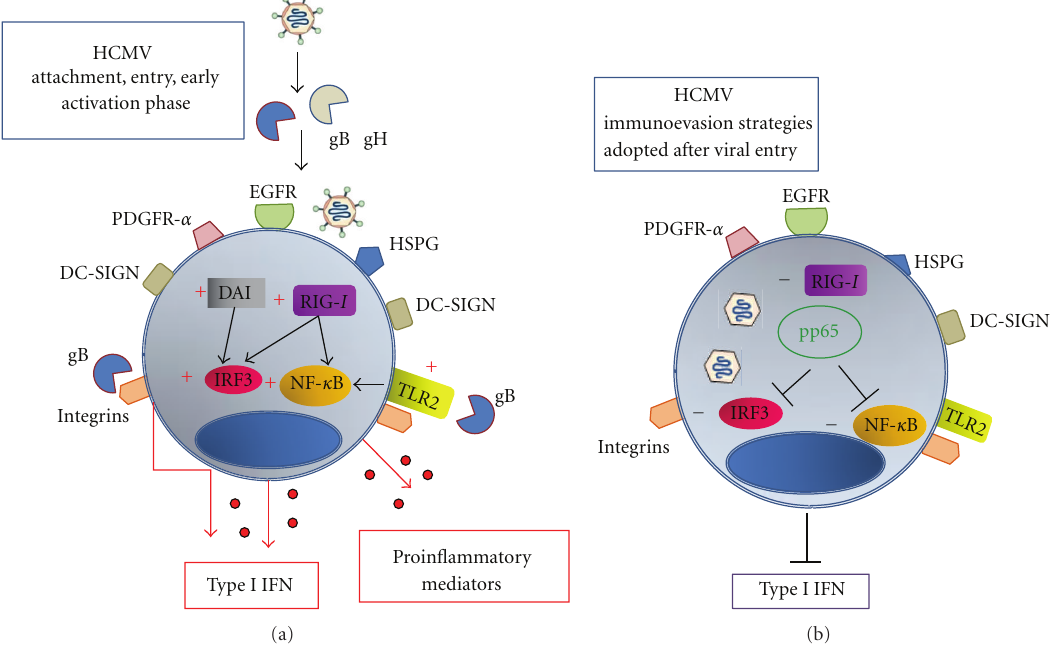
Figure 1: Activation and viral-induced modulation of early phases, HCMV attachment, entry, and intracellular phases of the viral cycle. (a) The binding of viral glycoprotein B (gB) induces the release of type I interferons (IFN) via IFN regulatory factor (IRF) 3, whereas contact between viral glycoproteins gB and gH and toll-like receptor (TLR)2 induces the activation of NF- κ B and the release of proinflammatory cytokines. Expression of the intracellular receptor retinoic acid-inducible gene I (RIG-I) is also upregulated in the early phases, the DNA sensor DNA-dependent activator of IFN-regulatory factors (DAI) is activated, triggering IRF-3 activation and type I IFN production. (b) After viral entry, HCMV immunoevasion strategies are activated. Virion-associated and newly produced pp65 prevents IRF3 activation and subsequently impairs the production of type I IFN. Viral pp65 also inhibits NF- κ B activation. RIG-I is downmodulated by an unknown mechanism, likely contributing to reduced IFN production. +; upregulation or activation, − ; downmodulation or